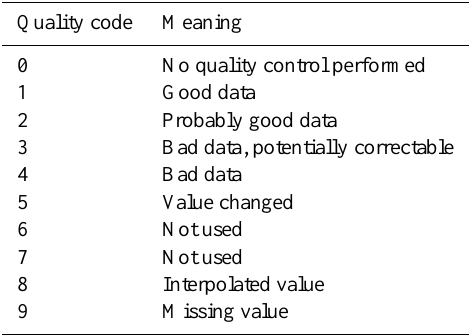
Table 2. Quality flags and their